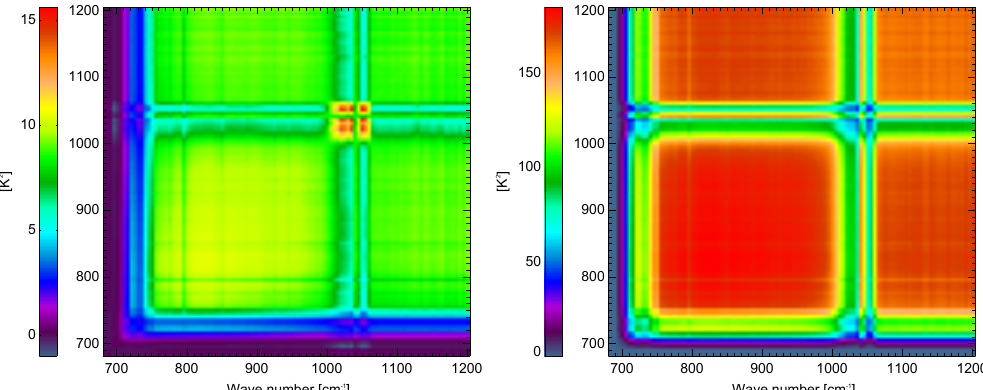
Figure 1. The measurement error covariance matrices created using IASI data from (a) clear-sky scenes and (b) cloudy scenes for the latitudinal band 30–60 ◦ N